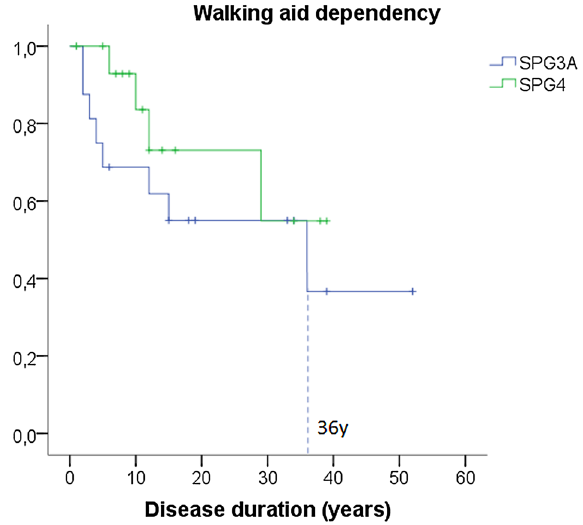
Figure 3. Progression to major handicap in SPG4 and SPG3A. The figure shows Kaplan–Meier analysis of loss of independent walking to disease duration for individuals with SPG4 and SPG3A. Median values of any walking aid assistance for SPG3A is informed and highlighted by dashed